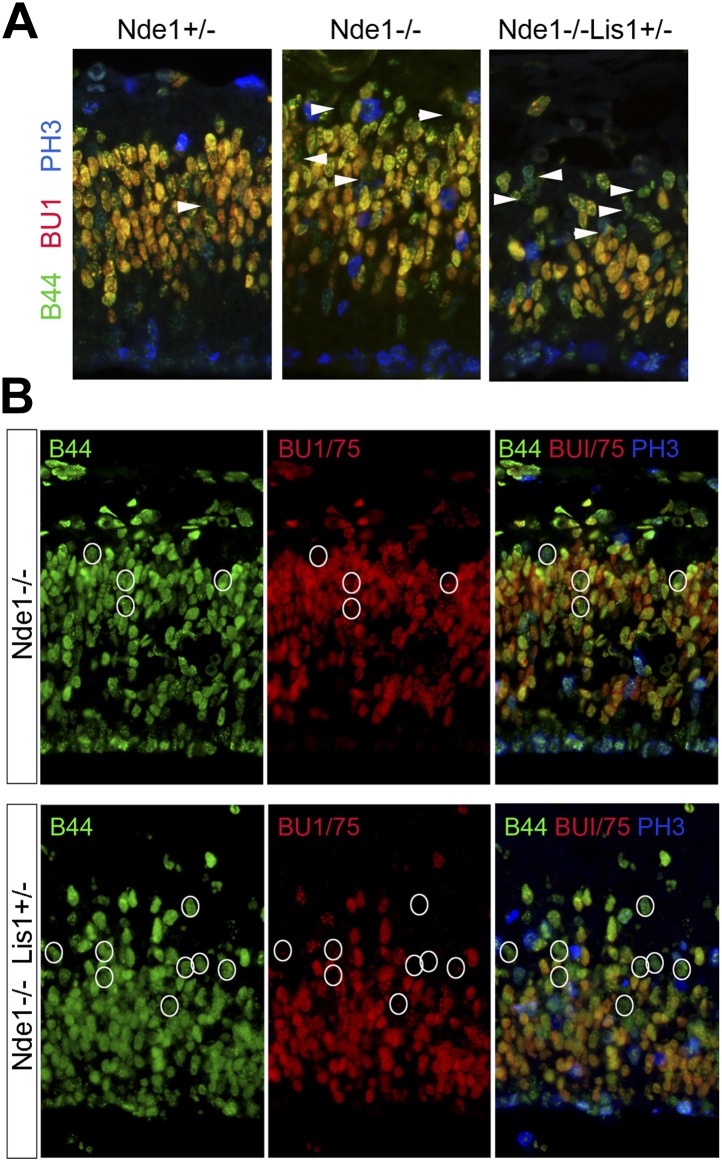
Stalled or delayed DNA replication in Nde1 mutant neural progenitors.(A) Triple immunofluorescence histological staining of neocortical sections with B44 (green), BU1/75 (red), and PH3 (blue), showing the lack of PH3 immunoreactivity in the arrow-indicated B44+BU1− cells of Nde1−/− and Nde1−/−Lis1+/− cortices. (B) Representative images of B44 (green), BU1/75 (red), and PH3 (PH3) triple immunohistological staining after IdU (2.5 hr), BrdU (30 min) sequential labeling. Note the B44+BU1/75−PH3− cells (circles) in the S phase region of Nde1−/− and Nde1−/−Lis1+/− cortices.